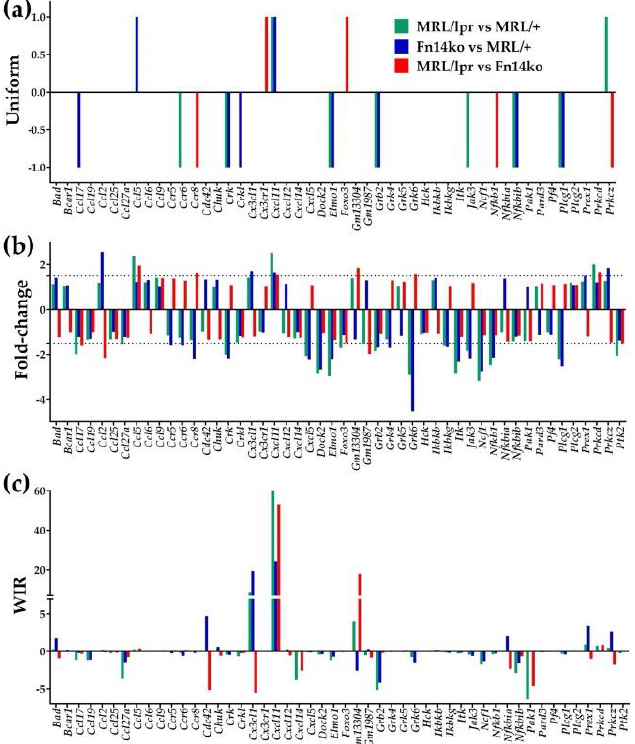
Figure 2. Three measures of comparative expression regulation illustrated in a sample of chemokine-signaling genes. ( a ) Uniform (+1/−1 for up-/down-regulated genes). ( b ) Fold-change (negative for down-regulation). ( c ) Weighted Individual (gene) Regulation (WIR), or the weighted contribution of each gene to the transcriptome. A gene was considered as significantly differentially expressed between two phenotypes if: (1) its absolute fold-change exceeded the cut-off for that gene, considering the contributions of both technical noise and biological variability, and (2) the p -value of the heteroscedastic t -test of the means’ equality was <0.05. 3.3. Regulation of Signaling Pathways and NPSLE Biomarkers Going beyond individual genes, we proceeded to examine relevant pathways that may be differentially regulated in the setting of NPSLE. Increased levels of pro-inflammatory cytokines and chemokines in the brains of SLE patients are thought to play an important role in the development of neuropsychiatric manifestations [3]. In addition, neurotransmission is often the final outcome of signaling pathways in the brain and a key shaper of neuronal networks, which have been shown to be significantly altered in the context of NPSLE [28]. We therefore chose to focus on major KEGG-derived neurotransmission and chemokine signaling pathways that may